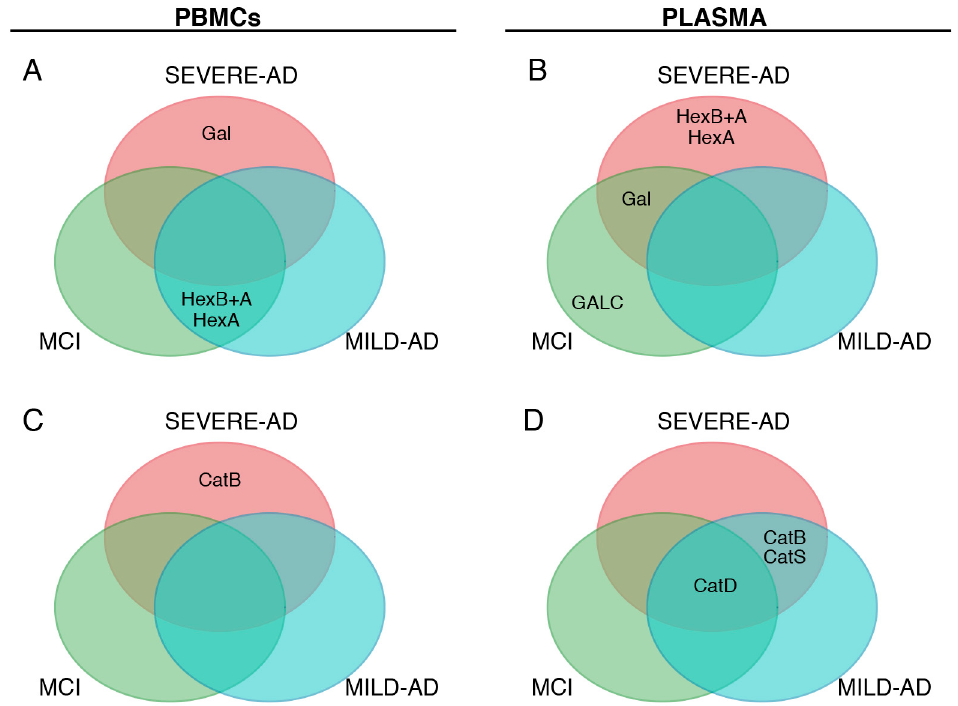
Figure 6. Lysosomal enzymes are able to discriminate mild AD, severe AD, MCI, and control subjects. The Venn diagram illustrated the relationship between mild AD, severe AD, and MCI groups, where lysosomal enzymes showed statistical variation with respect to control group ( A – D ).